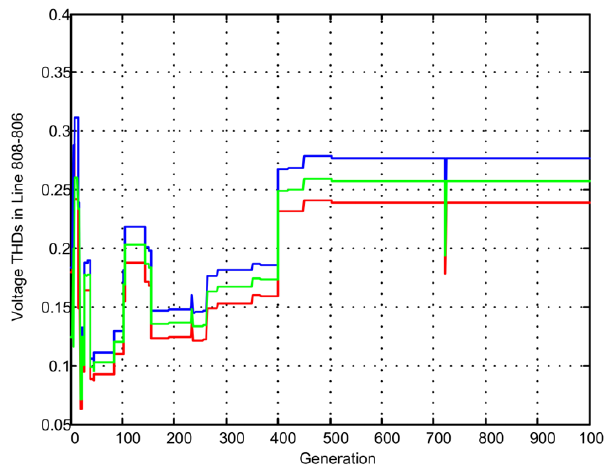
Figure 9. Voltage THD over GA iteration at branch